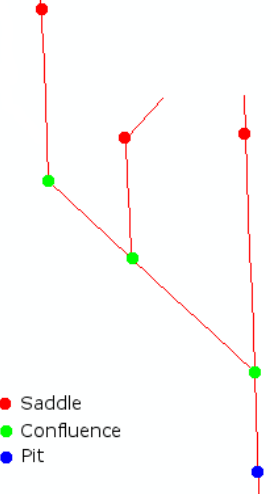
Figure 3: Surface network and contour lines (plain) of a terrain from (Cort´es Murcia et al., 2016)